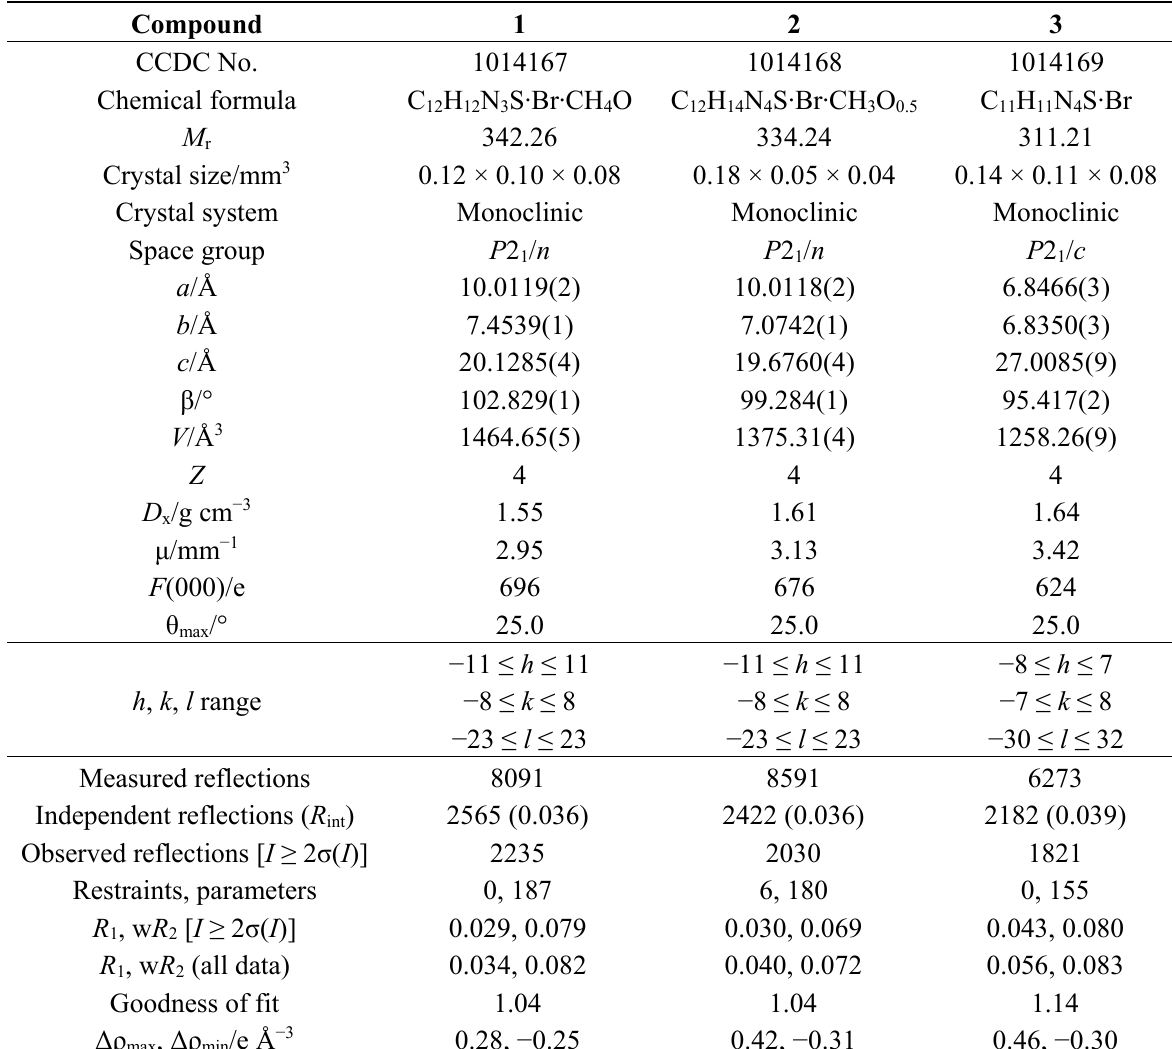
Table 1. Crystal data and refinement